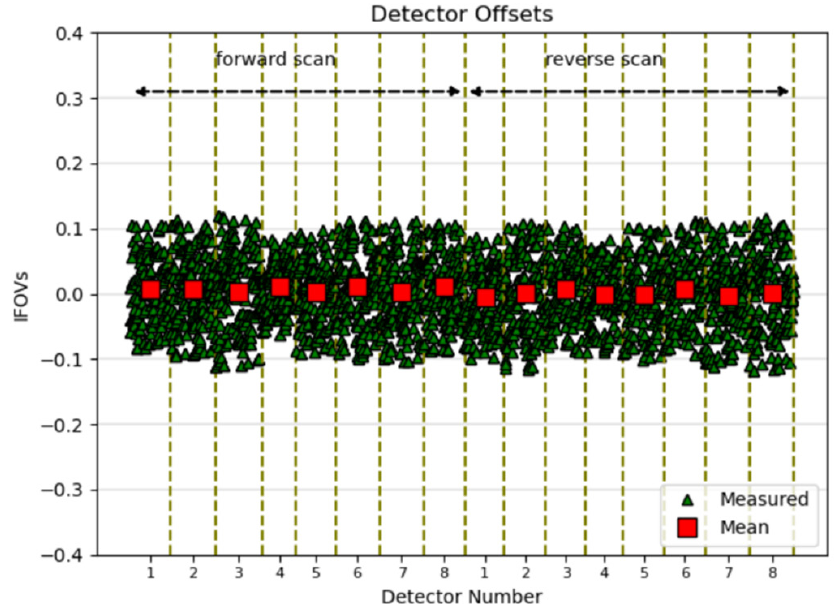
Figure 7. Thermal band detector displacements for the ETM+. Collection 2 post-calibration measured offsets for the Landsat scene ID LE70390372003116EDC00 are shown for individual line-by-line measurements using green triangles, while the mean of those measurements is shown with red squares. Forward and reverse scan values for each detector are shown. Values are given concerning a thermal band detector IFOV.